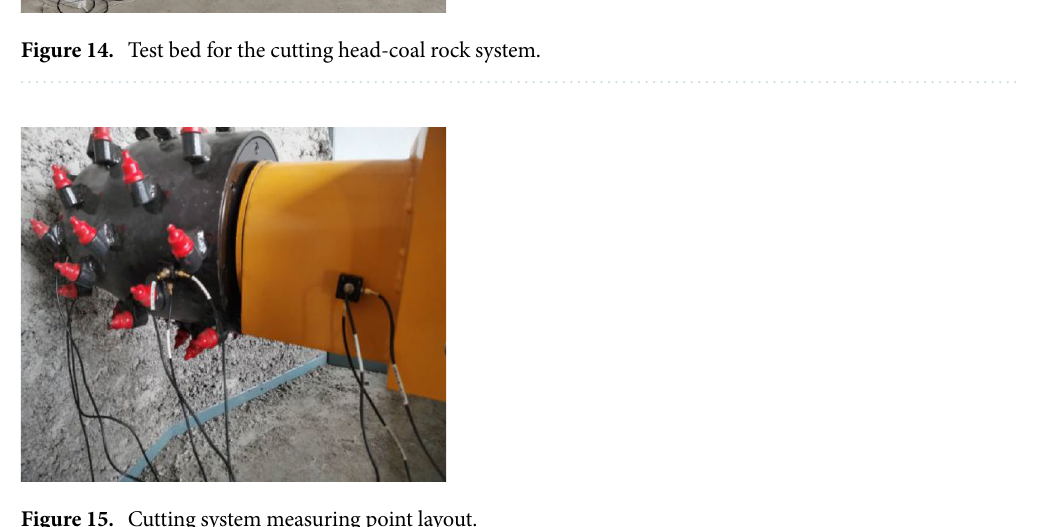
Figure 15. Cutting system measuring point